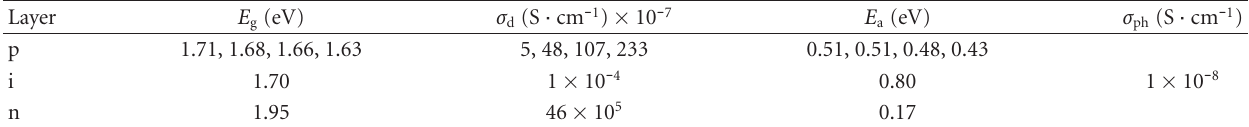
Table 3: Characteristic properties of the layers of solar cell, where σ ph (S · cm - 1 ) is photo conductivity.